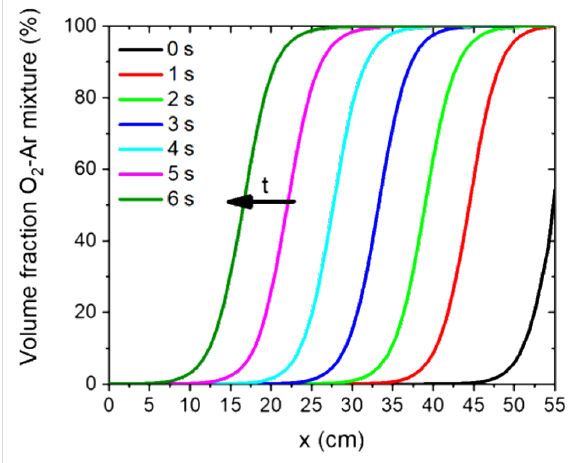
Figure 7: Simulated gas exchange in the quartz tube from 100% Ar to the O 2 /Ar mixture (5% O 2 in Ar) showing the transient behavior of the gas transition: simulated total volumetric flow of 25 sccm, inner quartz tube diameter of 5 cm, pressure of 20 mbar and process temperature of 850 °C were used.